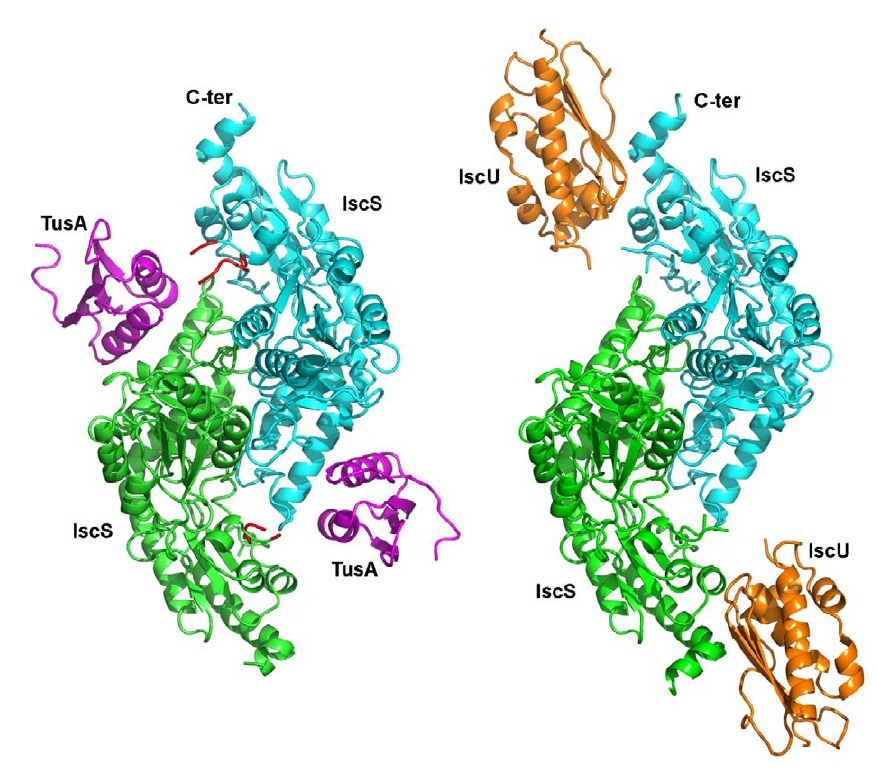
Figure 2. Crystal structure of IscS complexes. Cartoon representation of the IscS-TusA and IscS-IscU heterotetramers. The IscS subunits are colored cyan and green, TusA is magenta and IscU is orange. The Cys328 containing loops are red.